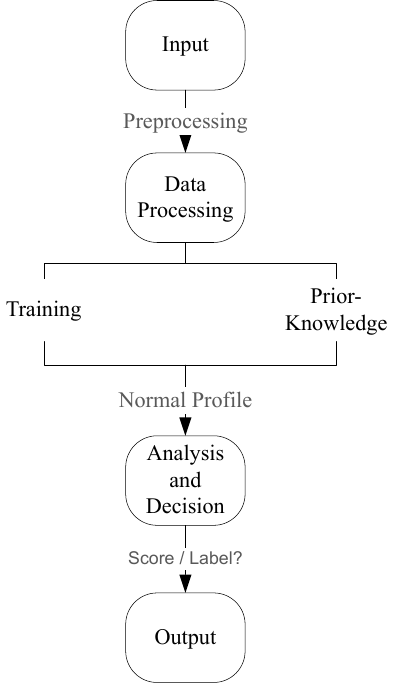
Figure 1. Generic Anomaly detection framework.